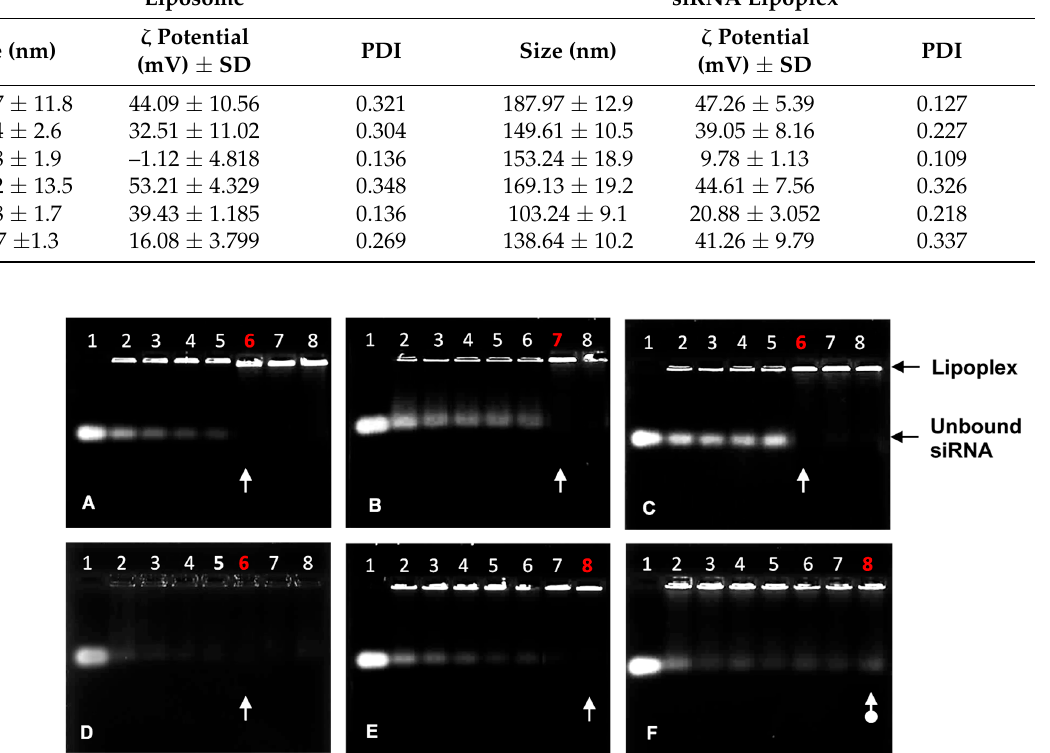
Figure 2. Band-shift assay showing the binding interaction between varying amounts of PEGylated and non-PEGylated cationic liposomes with siRNA (0.32 µg). ( A ) Chol-T: Lanes 1–8 (0, 3.20, 3.52, 3.84, 4.16, 4.48, 4.80, and 5.12 µg); ( B ) Chol-T 2% PEG2000: Lanes 1–8 (0, 6.08, 6.40, 6.72, 7.04, 7.36,